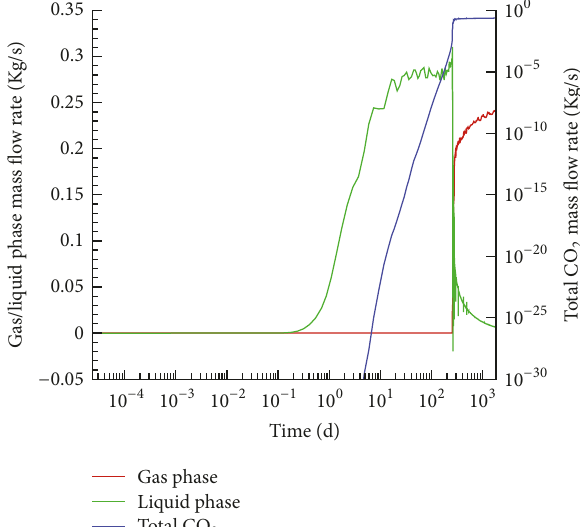
Figure 5: Mass flow rate evolution of the gas/liquid phase and total CO 2 at the outlet of Aquifer 1 in Case